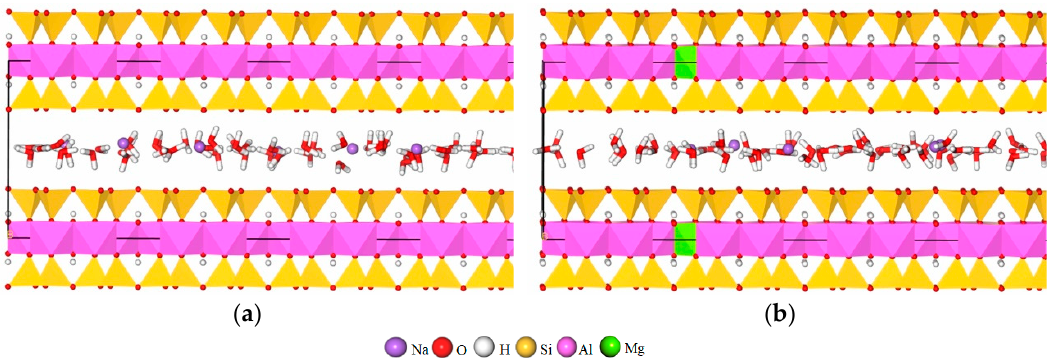
Figure 1. The models of Na-montmorillonite (Na-MT) before geometry optimization, ( a ) Na-MT1 0-6 ; ( b ) Na-MT1 6-0 .